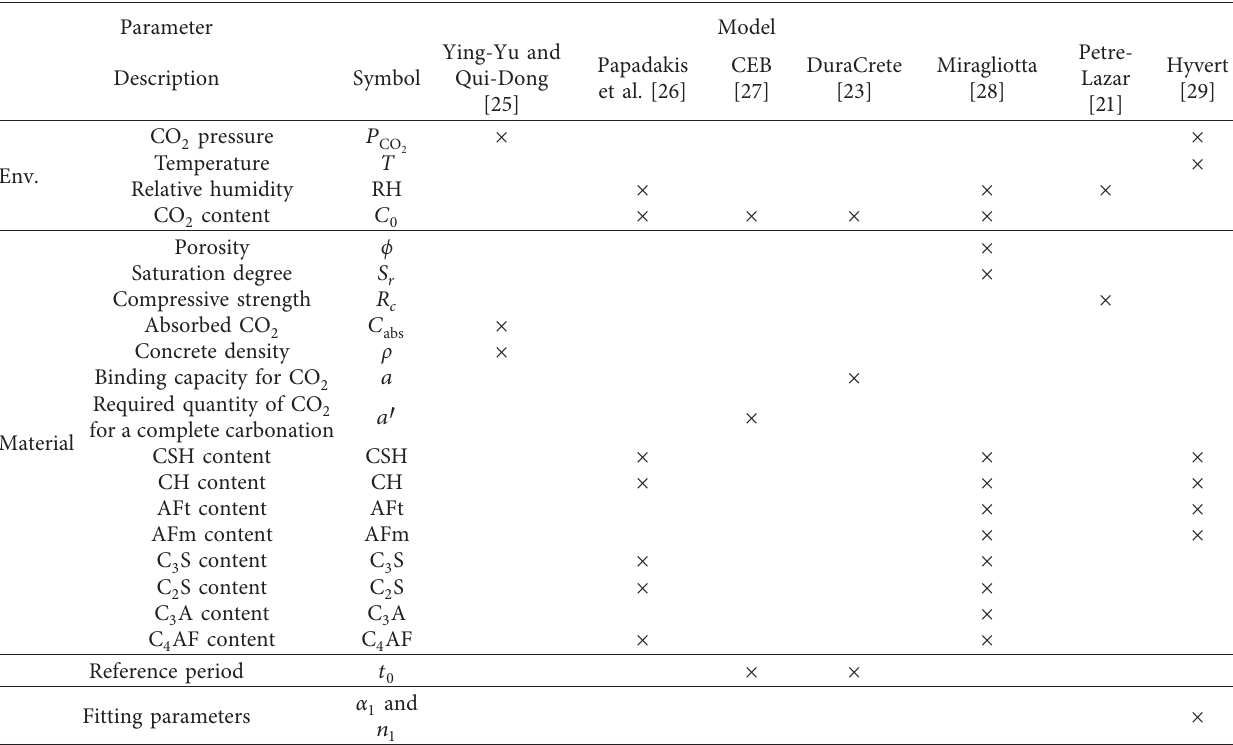
Table 4: Input parameters of analytical models of carbonation by Rakotovao Ravahatra et al. [17].